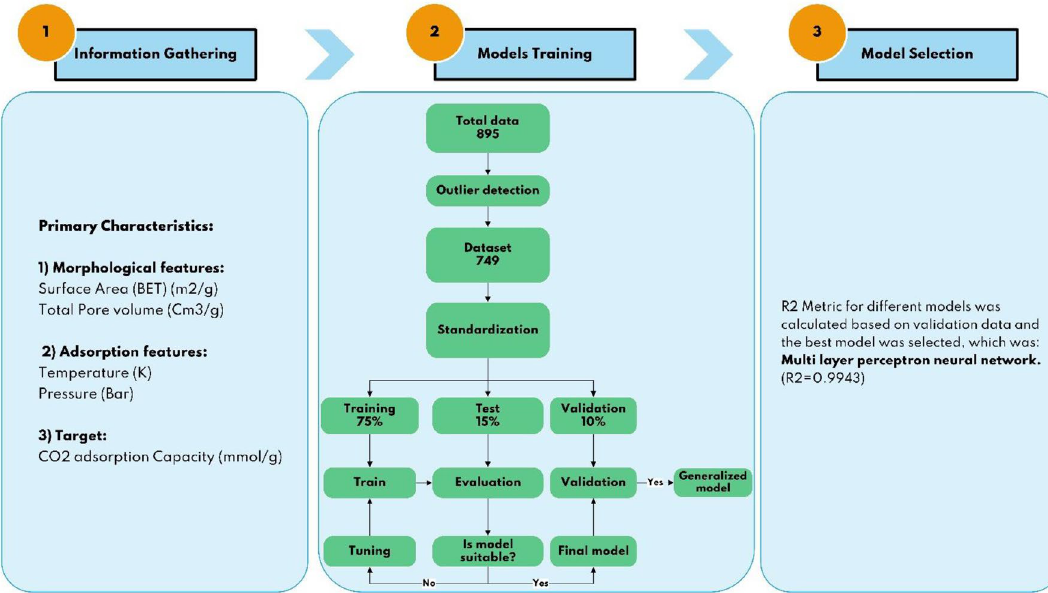
Figure 4. Procedure and algorithm diagram of the current machine learning-based modelling.